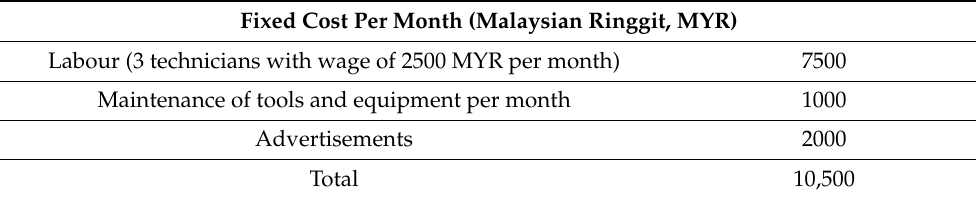
Table 20. Fixed cost per month for production and advertisements (case